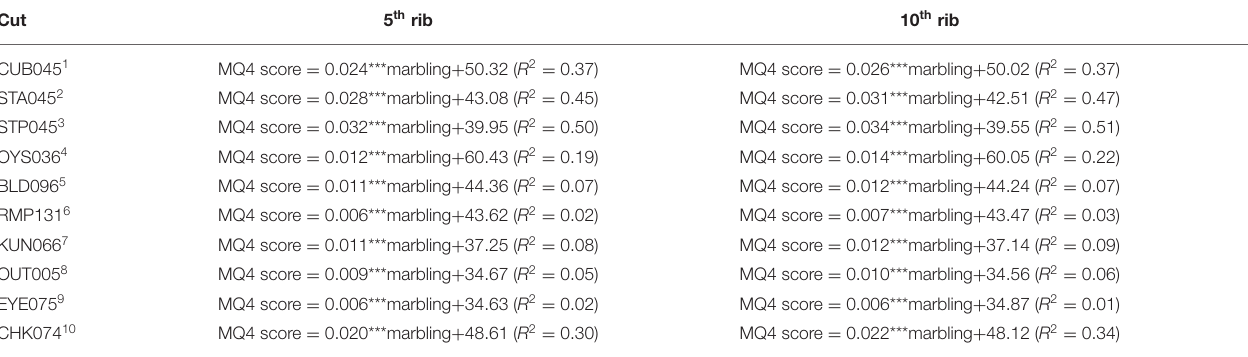
TABLE 5 | Linear regression equations for indicating the MQ4 score using the marbling score assessment at the fifth rib and the tenth rib. Cut 5 th rib 10 th